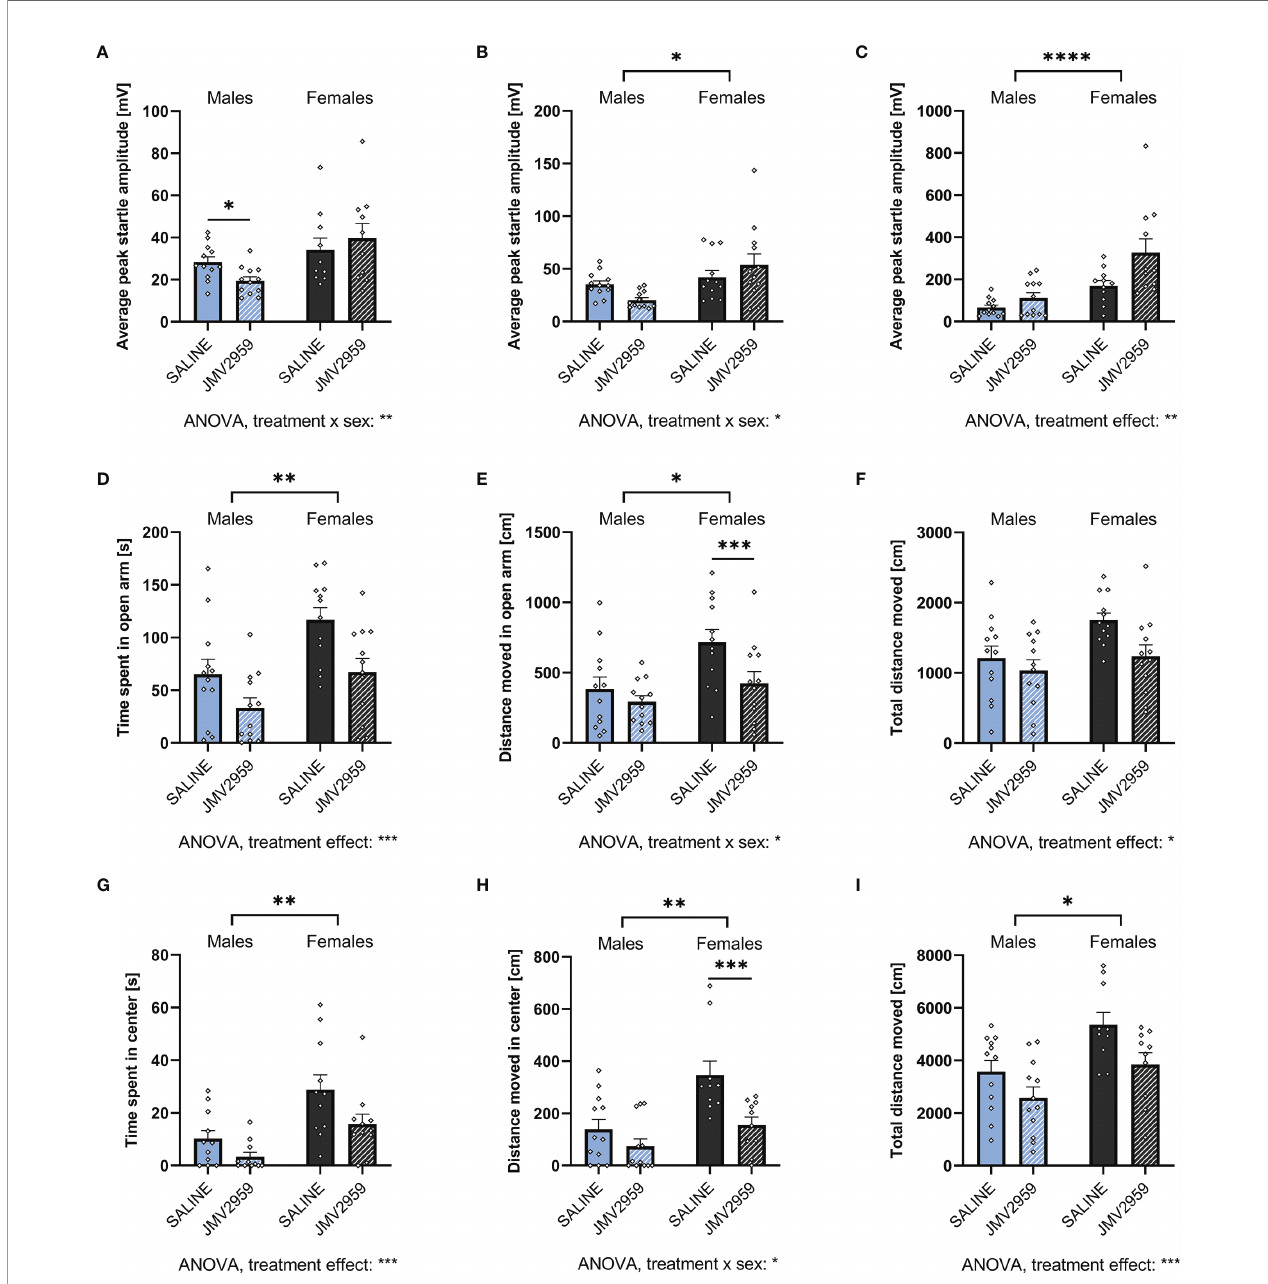
FIGURE 6 | Blocking endogenous ghrelin signaling is anxiogenic in ASR, EPM, and OF. Treating overnight fasted male and female rats with the ghrelin antagonist JMV2959 decreased the ASR after a 90dB white noise burst in males only (A) . At 95dB, no signi fi cant differences were detected in both males and females (B) . However, when exposed to a 105dB white noise burst, only JMV2959-treated females displayed an elevated startle response (C) . In the EPM, both males and females decreased the time spent in the open arm (D) , but only females also decreased the locomotion in the open arm (E) , and overall (F) . When tested in the OF, a decrease in time spent (G) and distance moved (H) in the center was only detected in females. Overall locomotion, however, was reduced in both sexes (I) . All data are presented as mean ± SEM. * p < 0.05, ** p < 0.01, *** p < 0.01, **** p < 0.0001 compared with respective controls. n = 12 per treatment group in each sex in the ASR and EPM, and n = 11 per treatment group in the open fi eld respectively. ASR, acoustic startle response; EPM, elevated plus maze; OF, open fi